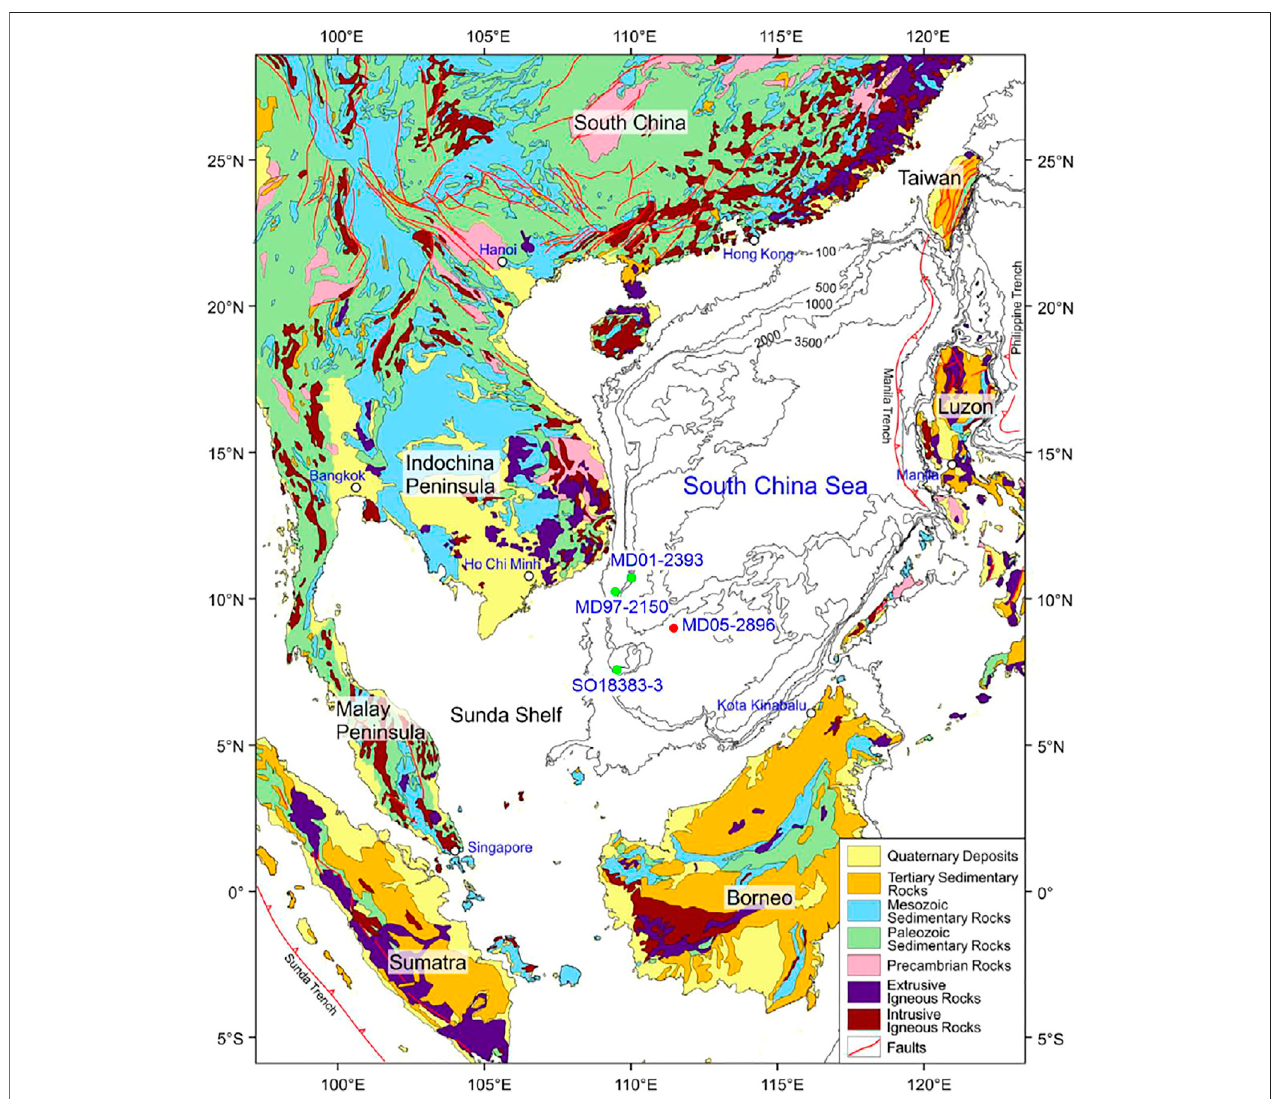
FIGURE 2 | Geological map of Southeast Asia surrounding the South China Sea (Liu et al., 2016). Locations of Core MD05-2896 (red circle) and referred cores (green circles) are indicated.